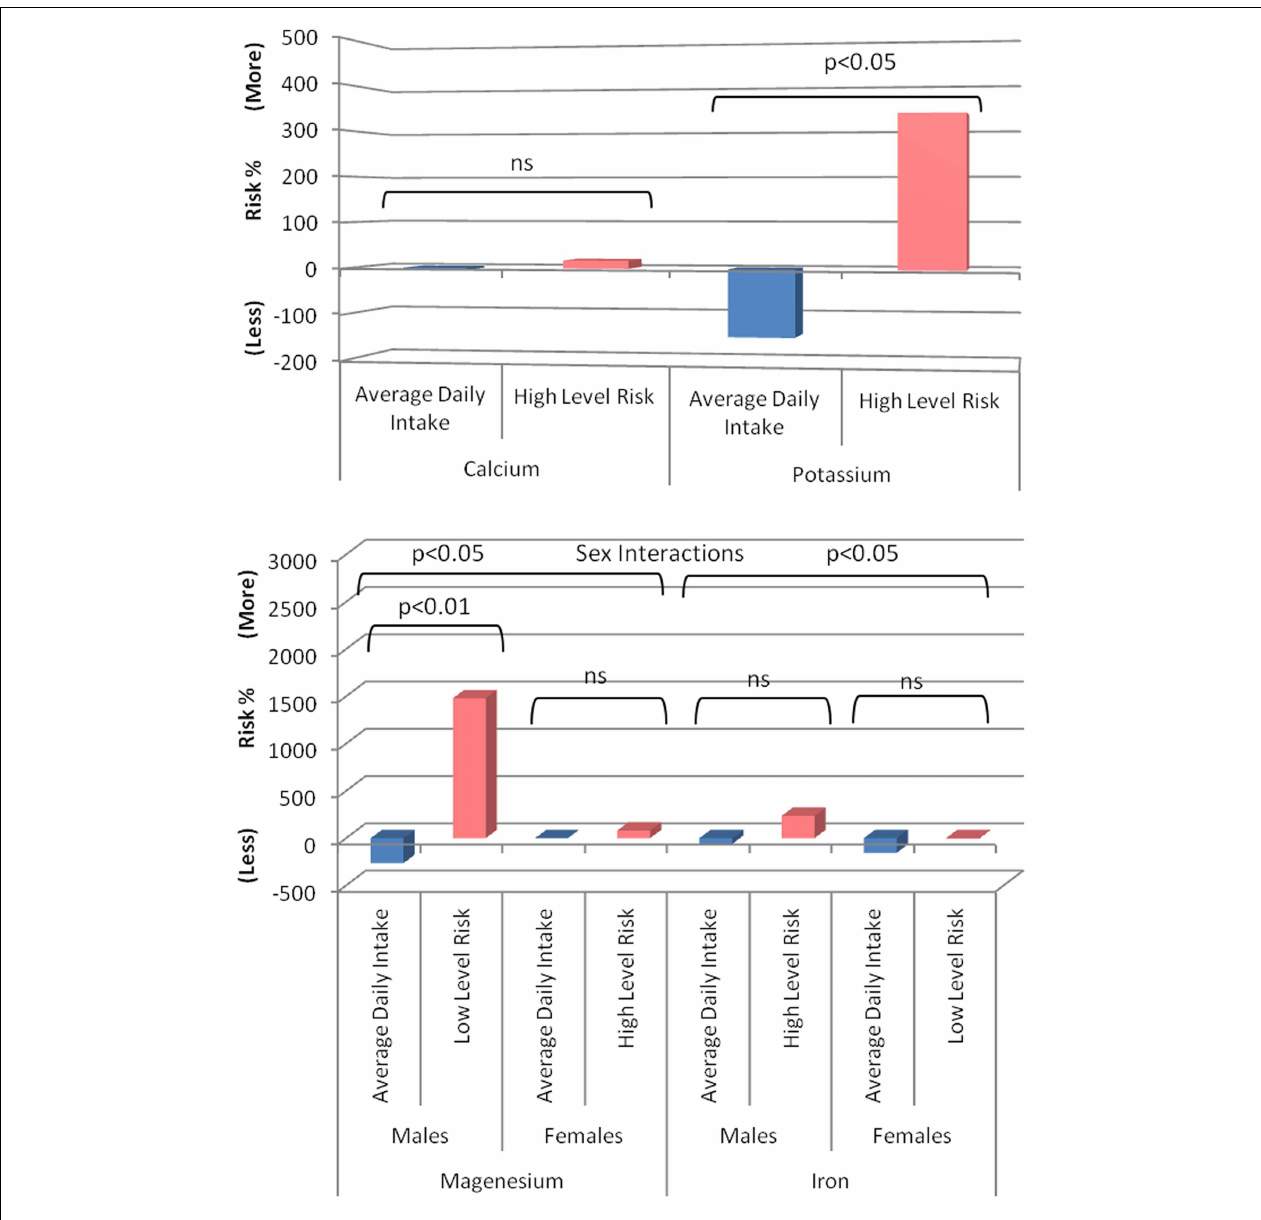
FIGURE 2 | Risk of developing MCI associated with minerals of interest in cognitively healthy individuals (blue, based on observed group mean intake relative to recommended intake from the NHMRC) compared to the risk associated with the NHMRC upper